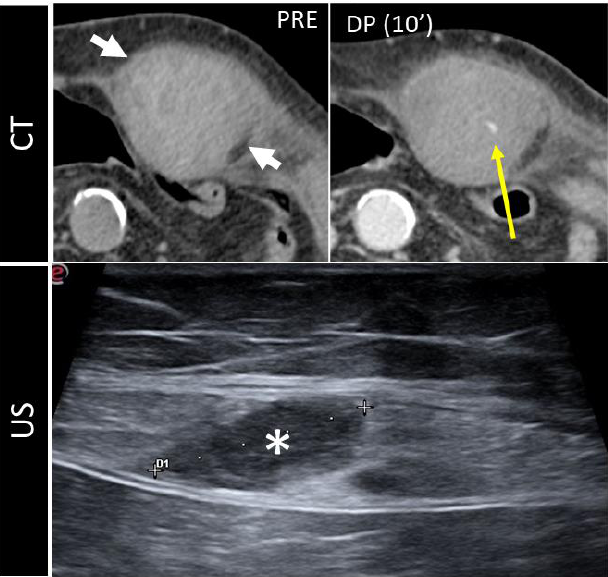
Figure 10. CT and US post-traumatic rectus sheath hematoma above the arcuate line. CT scan shows a well-defined mass, hyperintense on basal scan, in the context of the left rectus sheath (short white arrows). In the second picture, the delayed phase acquired 10 min after the injection of intravenous contrast demonstrates active bleeding (yellow arrow). The third picture shows the same lesion (*), studied some days later on US.